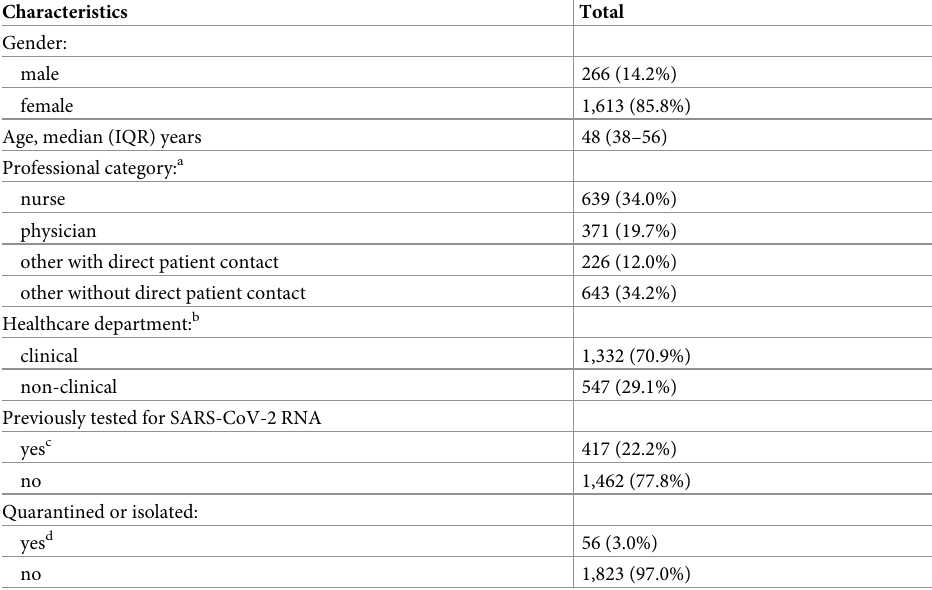
Table 1. Baseline characteristics of 1879